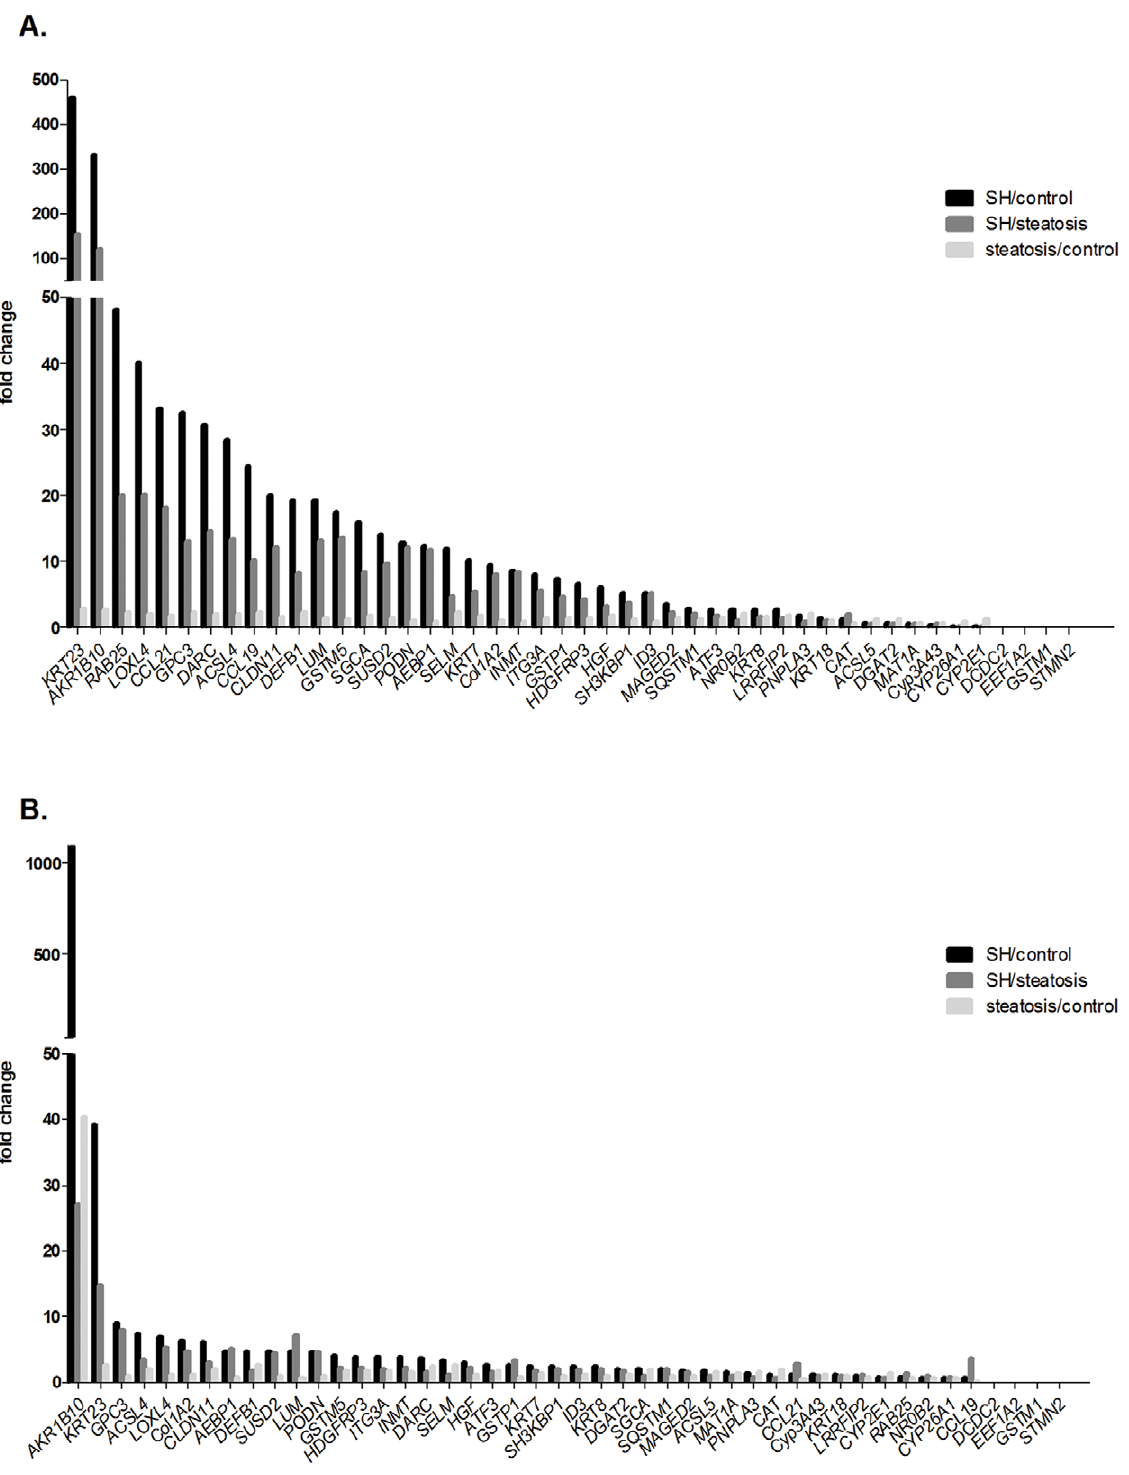
Figure 2. Fold changes of selected genes validated by qRT-PCR. The expression of selected target genes was determined in surgically collected samples (A) and in liver samples obtained by biopsy (B). The fold change was calculated by comparing the three groups of liver samples against each other.